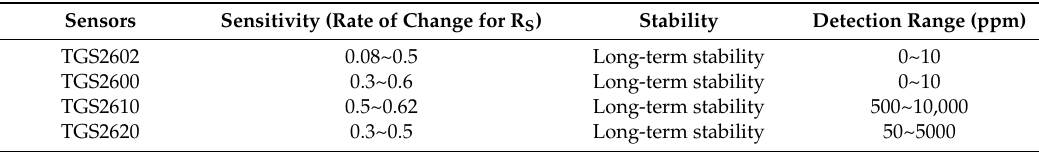
Table 2. The characteristics of the four types of sensors.